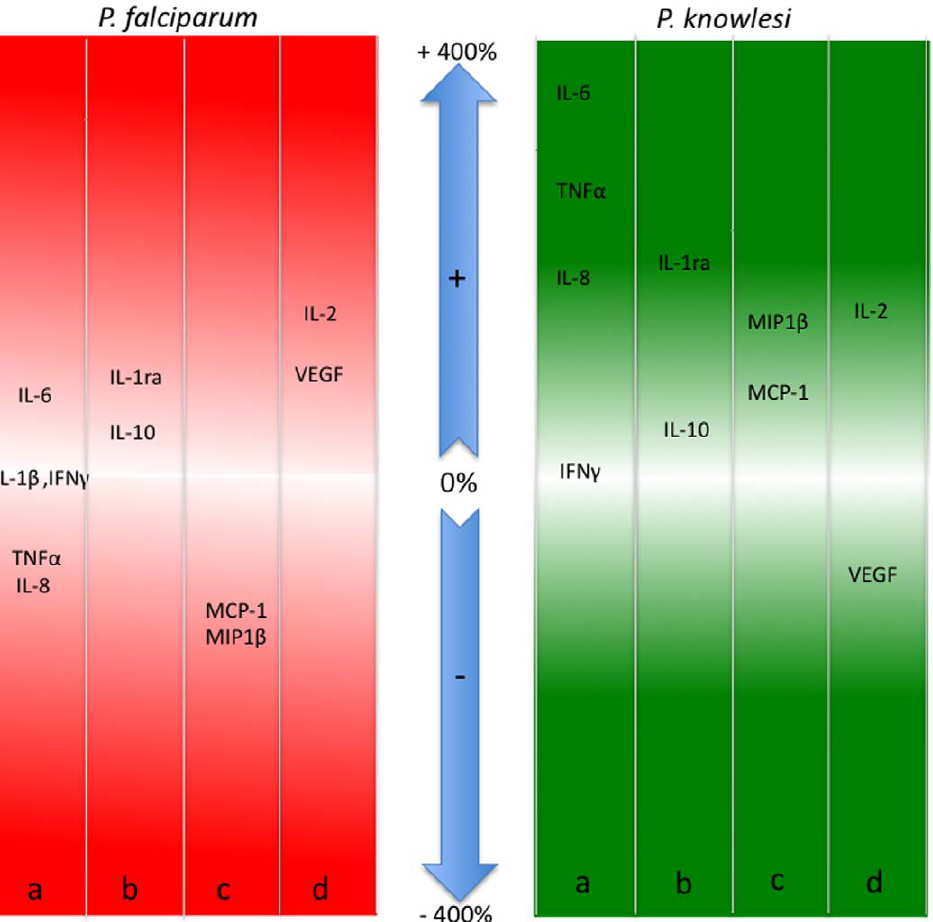
Figure 4. Diagrammatic representation of percentage change in median values of immune mediators between uncomplicated and complicated disease in P.falciparum and P.knowlesi infections as reported (Table 2). Columns show cytokines and chemokines grouped by function or cell source; a) pro-inflammatory, b) anti-inflammatory, c) macrophage/dendritic cell derived and d) IL-2 and VEGF growth factors. The arrows indicate percent and direction of